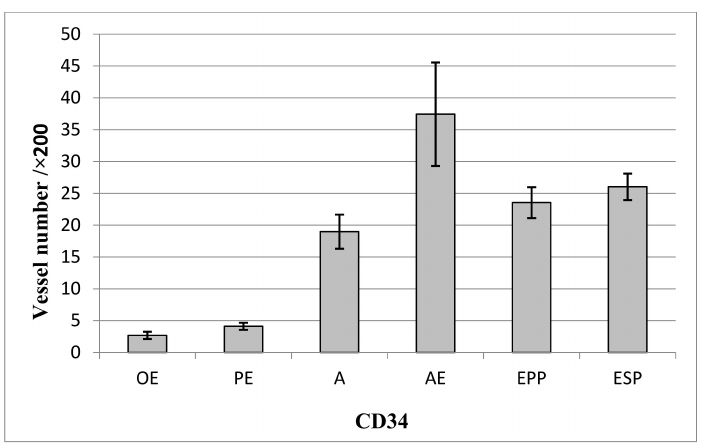
Scheme 2. Average vascular density (vessel number/ × 200) depending on the location of the eutopic/ectopic endometrium. OE = Ovarian endometriosis, PE = Peritoneal/pelvic endometriosis, A = Adenomyosis, AE = Abdominal wall endometriosis, EPP = Endometrium—proliferative phase, ESP = Endometrium—secretory phase, CD = cluster of